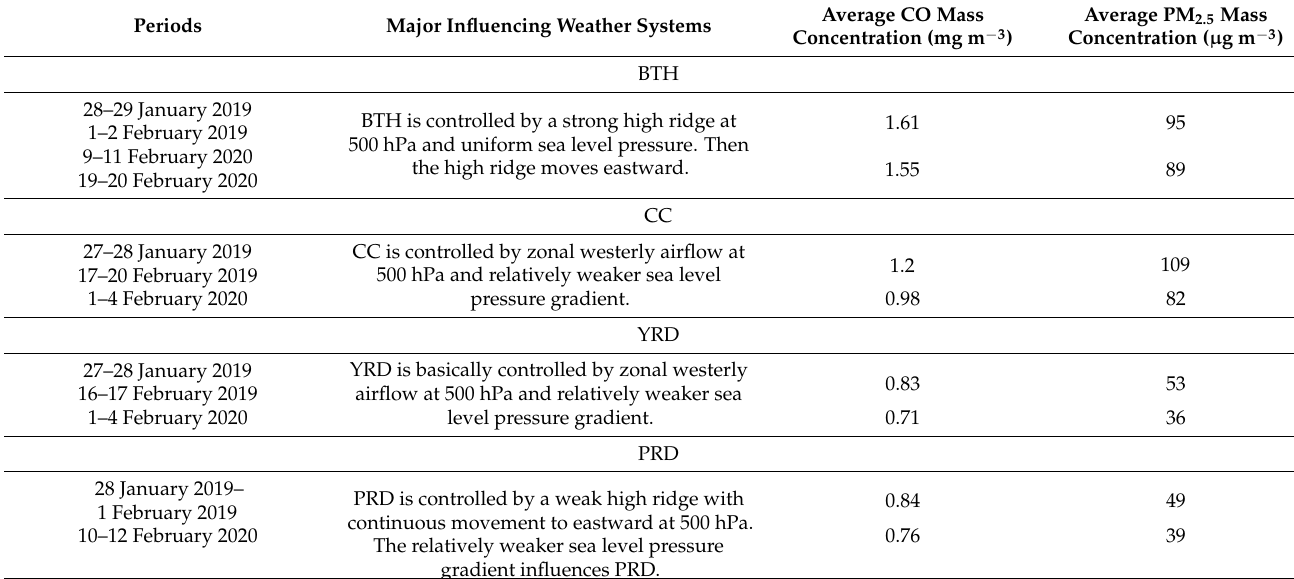
Table 4. The average CO mass and PM 2.5 mass concentration during periods associated with similar stable meteorological conditions in FMC_2019 and